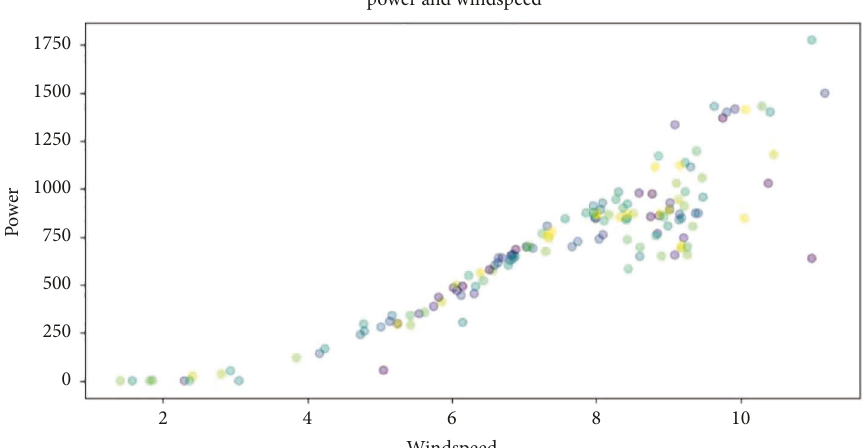
Figure 1: Data of power and wind speed.